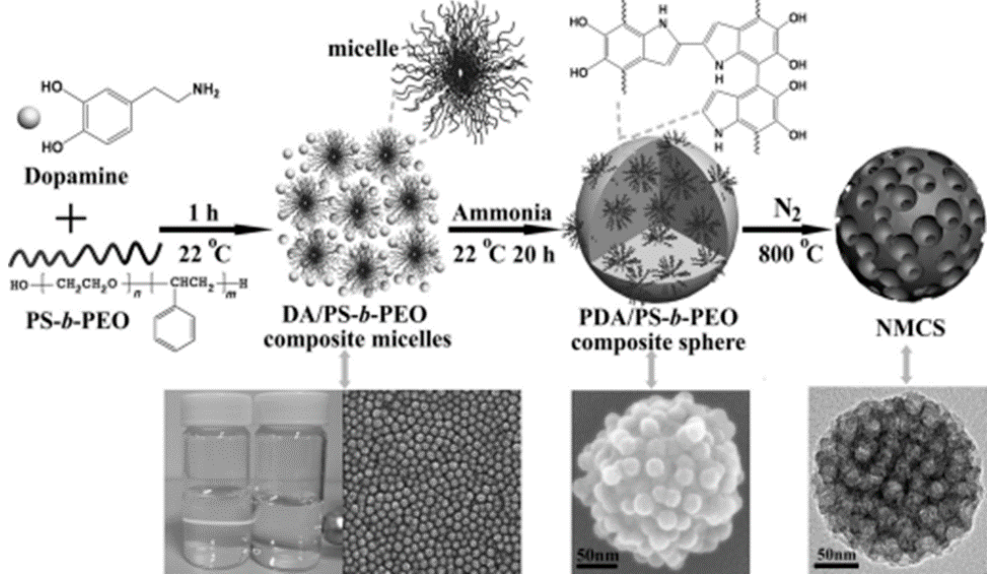
Figure 21. Synthesis of nitrogen-doped mesoporous carbon spheres (NMCS) with extra-large pores through the assembly of diblock copolymer micelles. Reprinted from Reference [152]. (Copyright (2015) WILEY-VCH Verlag GmbH & Co. KGaA, Weinheim).